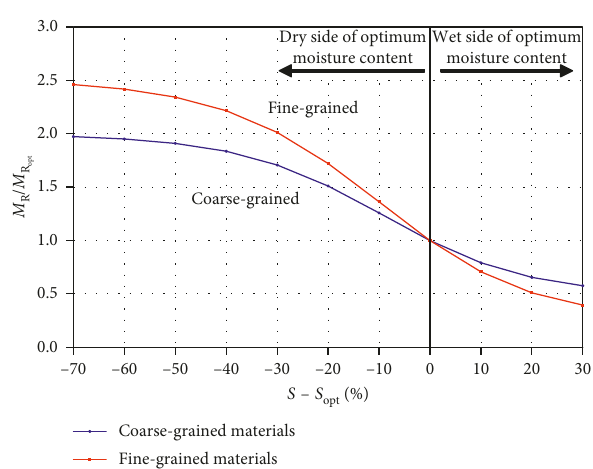
Figure 1: Effect of moisture changes on the resilient